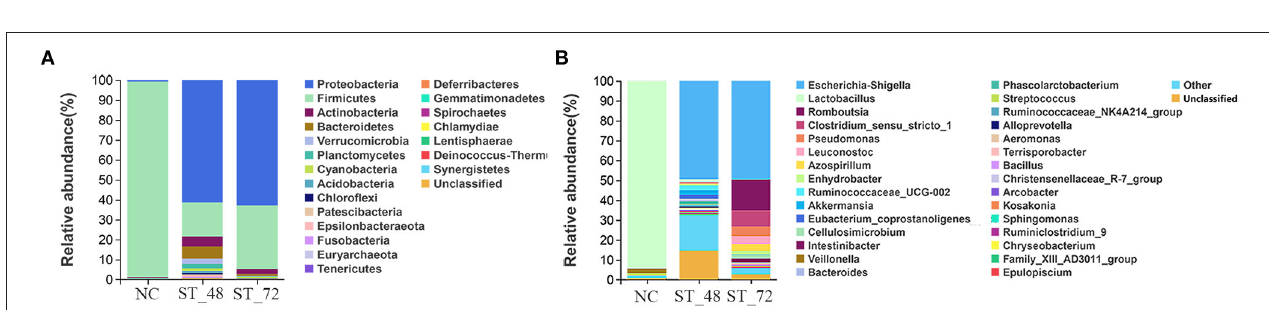
FIGURE 4 | Diversity of intestinal microbiota composition of piglets starved for 48 and 72h and the control group. Changes in microbial composition of each sample constructed at the (A) phylum and (B) genus levels (Top 30 in abundance).